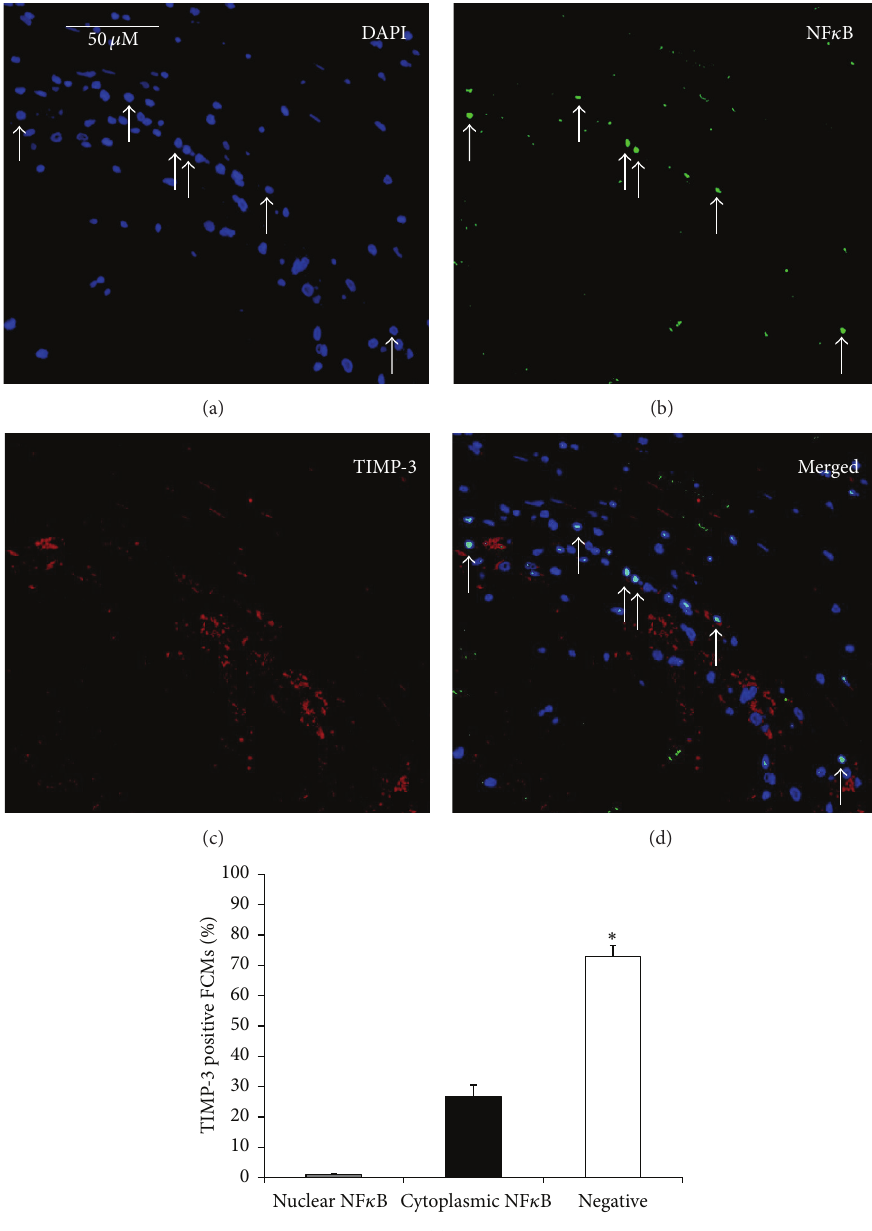
Figure 5: Immunohistochemical staining of carotid plaque sections for (a) 4 󸀠 ,6-diamidino-2-phenylindole (DAPI), (b) NF 𝜅 B, (c) TIMP- 3, and (d) merged, demonstrating that the percentage of TIMP-3 positive FCMs with no nuclear NF 𝜅 B was significantly greater ( 𝑛 = 20 , ∗ 𝑃 < 0.0001 ) compared to cytoplasmic or nuclear NF 𝜅 B staining, as depicted in adjoining graph